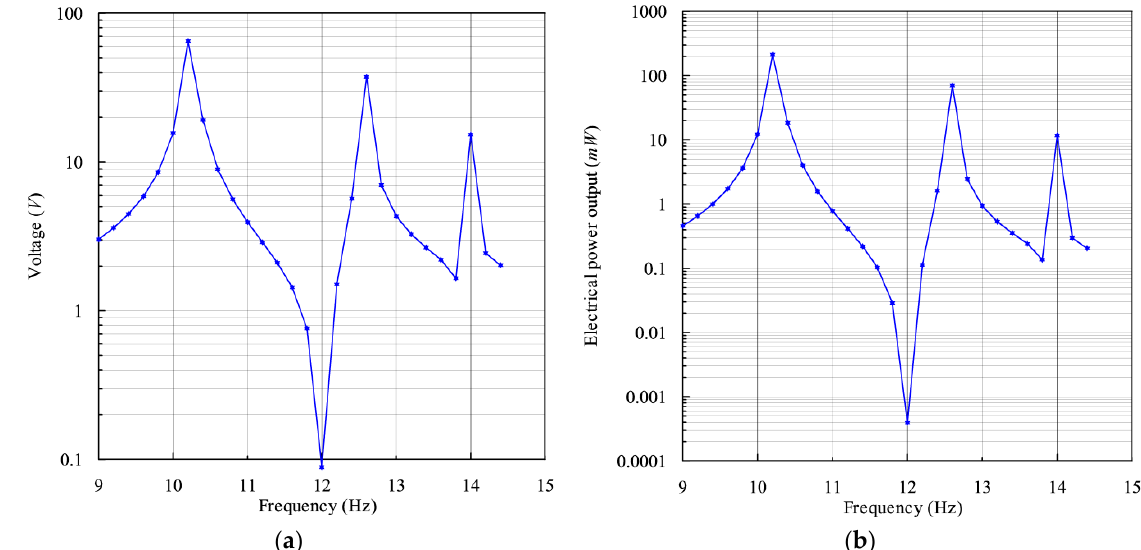
Figure 5. Frequency response under constant load and base excitation: ( a ) Voltage ( V ) and ( b ) Power ( mW ).